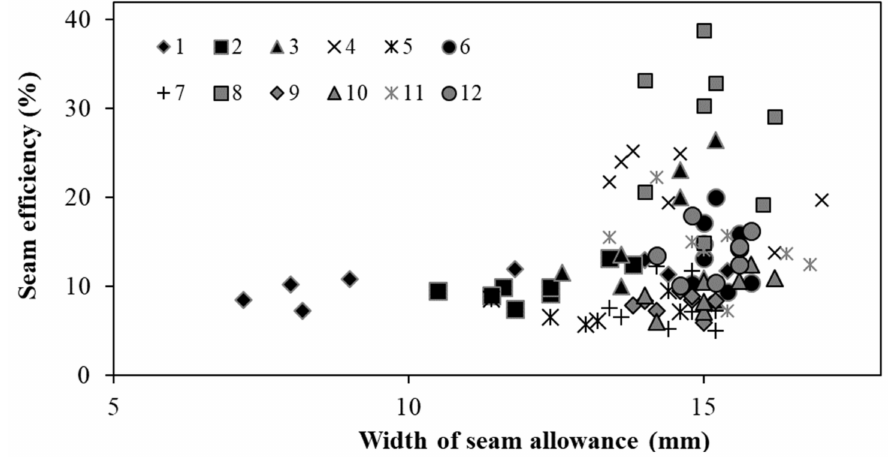
Figure 6. Seam efficiency of the lock stitch according to the width of the seam